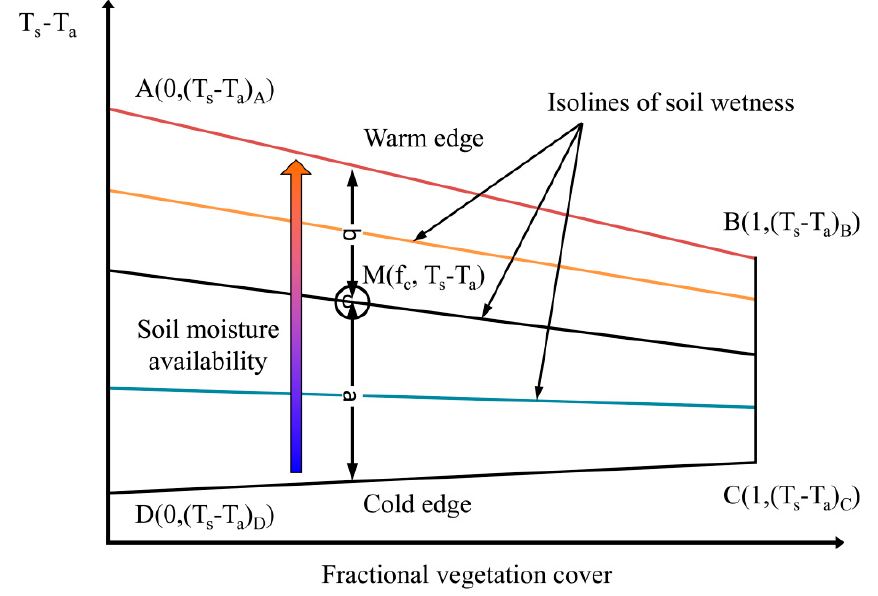
Figure 1. A sketch of the trapezoid in the vegetation fractional cover and LST (VFC/LST) space.